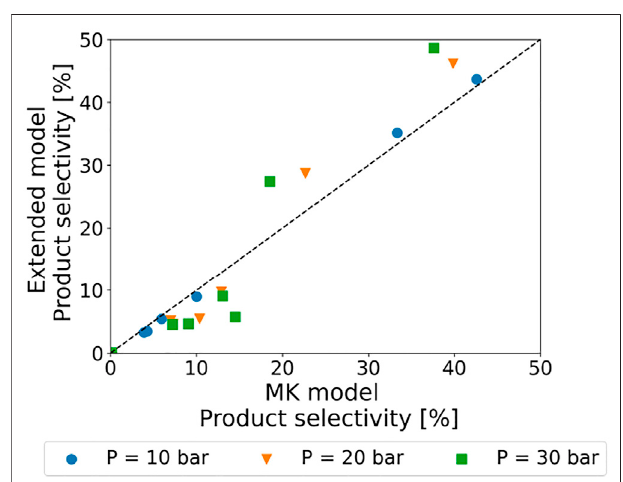
FIGURE 8 | Parity plot to compare the selectivity for ethylene, butene, and heavier ole fi ns at varying feed pressures using the extended MK model and the MK model used to validate the ROK